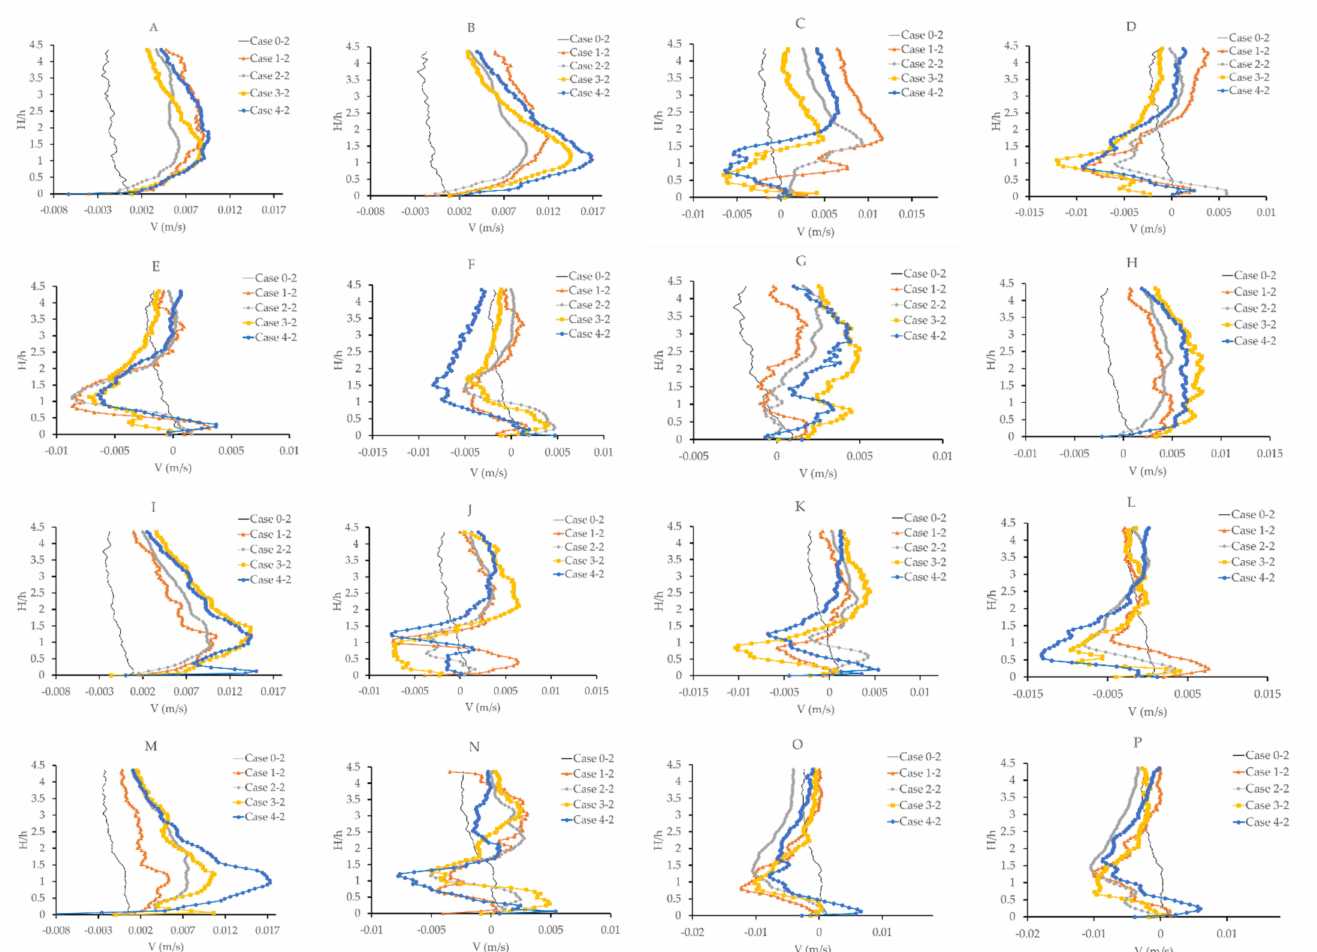
Figure 7. Vertical velocity distribution of each section of M-shaped unit